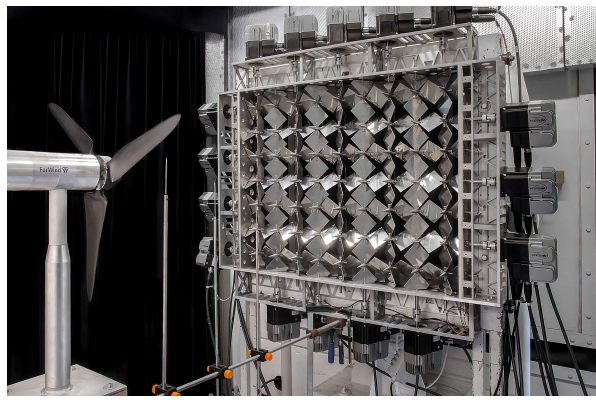
Figure 3. The model wind turbine and the active grid installed in a wind tunnel of the University of Oldenburg.